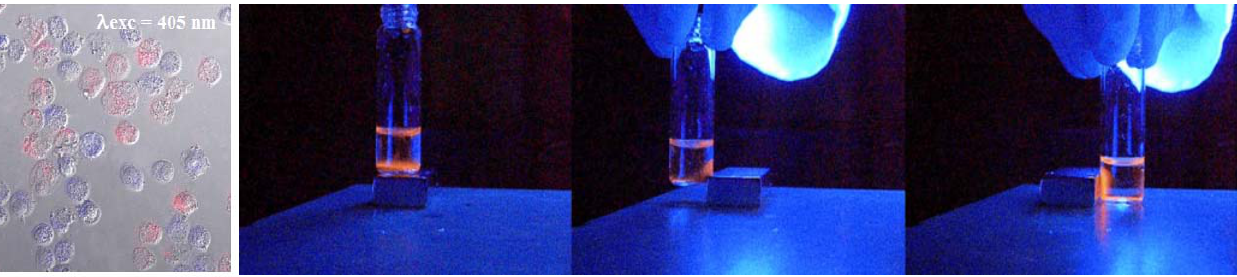
Figure 14. Confocal image of KB cells treated with OTF1-  -Fe